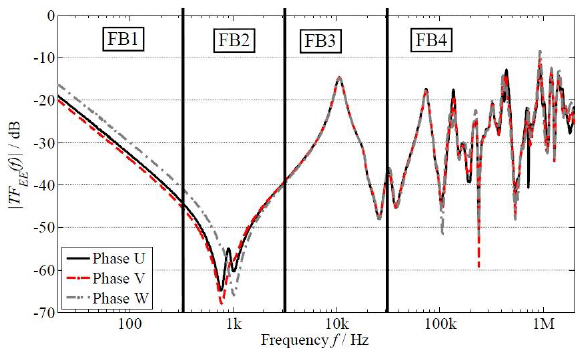
Figure 15. Characteristic frequency bands of measured end-to-end frequency responses of a three phase power transformer [33].